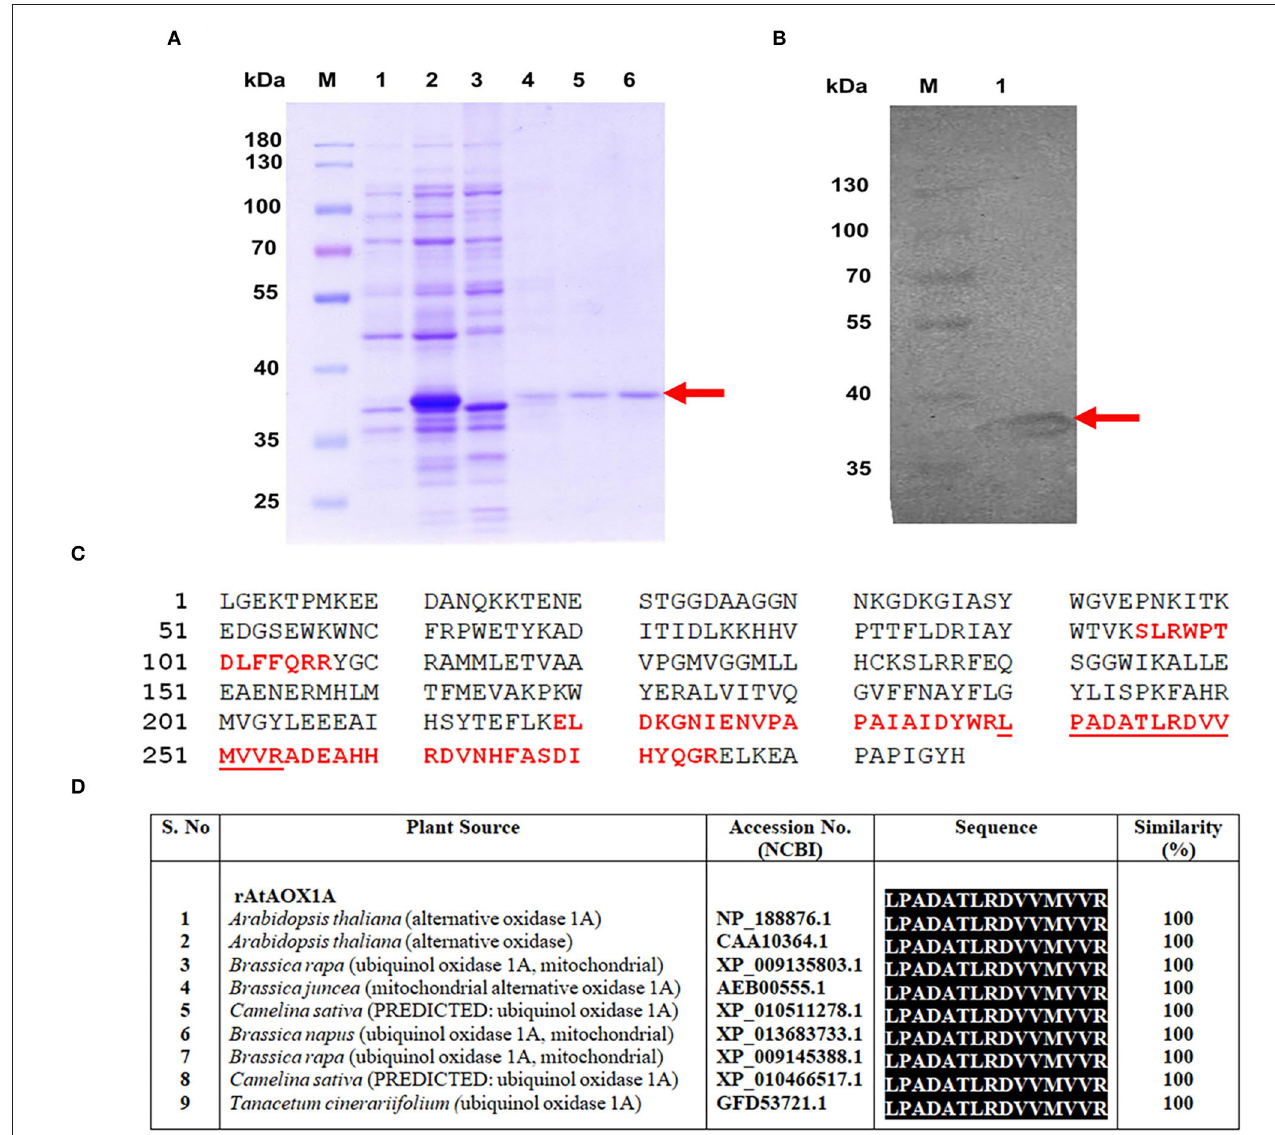
FIGURE 3 | Purification and validation of rAtAOX1A protein using MALDI-MS-MS. (A) SDS-PAGE visualizing purification profile of rAtAOX1A from E. coli . Lane M, 10-180 kDa protein marker; lane 1, protein from E. coli /pAtAOX1A; lane 2, protein from E. coli /pAtAOX1A induced with IPTG; lane 3, flow-through; lane 4, washing fraction; lanes 5 and 6, elution fractions, arrow indicates purified rAtAOX1A with ∼ 37 kDa molecular mass. (B) Western blot showing purified rAtAOX1A: lane M, 10-180 kDa protein marker; lane 1, 40 µ g of purified rAtAOX1A. (C) A. thaliana partial AOX (gi/1872517) sequence from NCBI database. The sequence of MS peaks (1209.854, 1365.972, 1566.099, 1656.258, 2385.628, and 2476.697 Da) of rAtAOX1A are indicated in bold red font, and sequence coverage from these six major peaks is about 24%. The obtained sequence from peptide peak m/z 1656.258 (‘LPADATLRDVVMVVR’) has shown 100% identity with AtAOX1A in BLAST search (D) . The gel picture shown is the selective representation of three biological